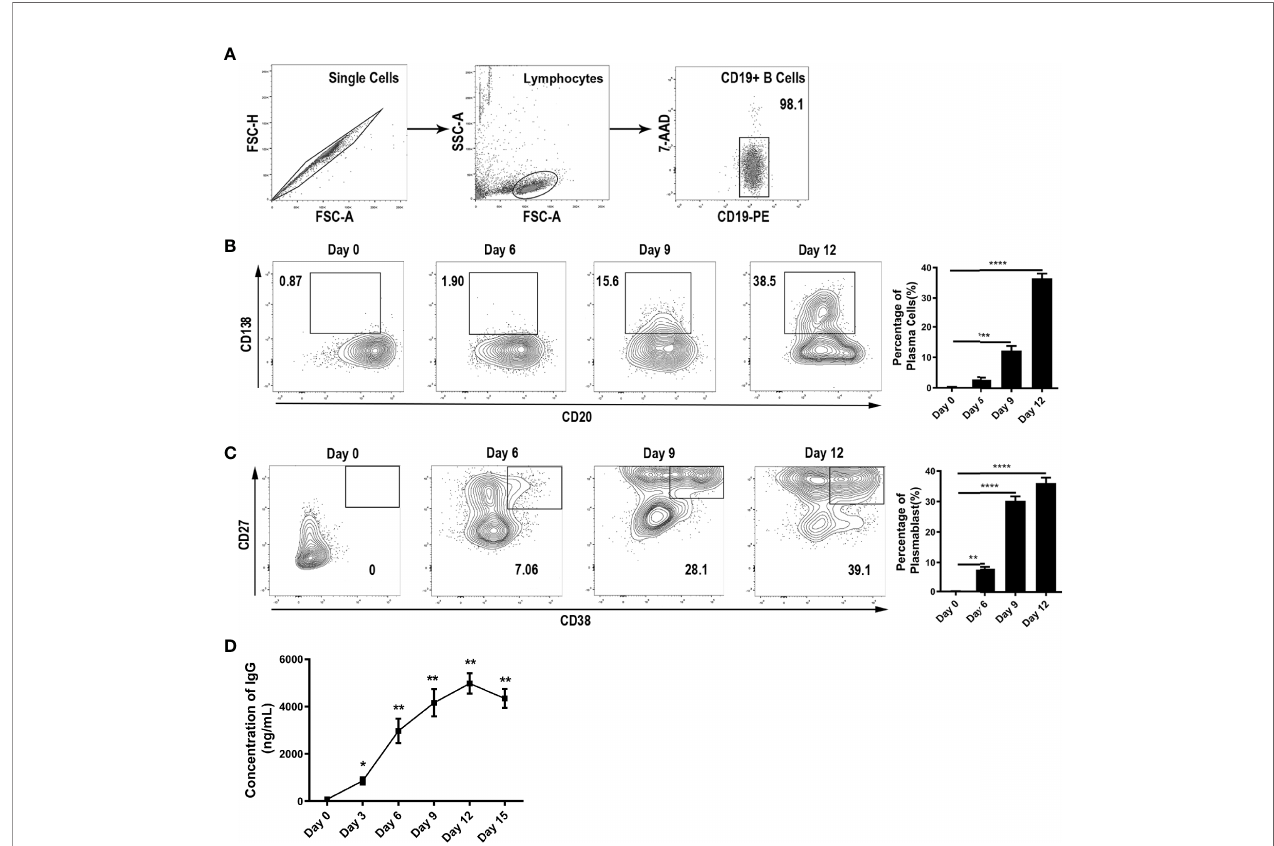
FIGURE 2 | B cell differentiation into ASCs in vitro . (A) Purity of B cells after sorting by immunomagnetic beads. (B – C) Differentiation of B cells into ASCs was monitored by fl ow cytometry via the surface expression of CD138, CD20, CD27, and CD38 on Day 0, Day 6, Day 9, and Day 12. All events were gated by the 7- AAD neg population. The population of CD138 + CD20 low represented plasma cells, and the CD27 high CD38 + population represented plasmablasts. The bar charts shown on the right indicate the percentage of ASCs along with the stimulation time. The error bars represent the SD. *p < 0.05, **p < 0.001, ***p < 0.0001, ****p < 0.00001. (D) Measurement of IgG in the culture medium was carried out continuously for up to 15 days. The error bars represent the standard deviation (SD). * p < 0.05 vs. Day 0, ** p < 0.001 vs. Day